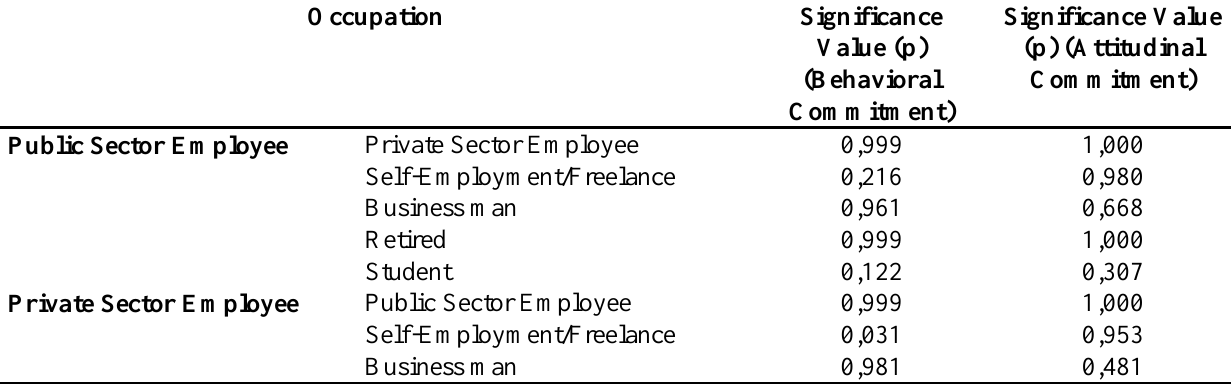
Table 17. Multiple comparison - Tukey test - results regarding profession vs. behavioral and